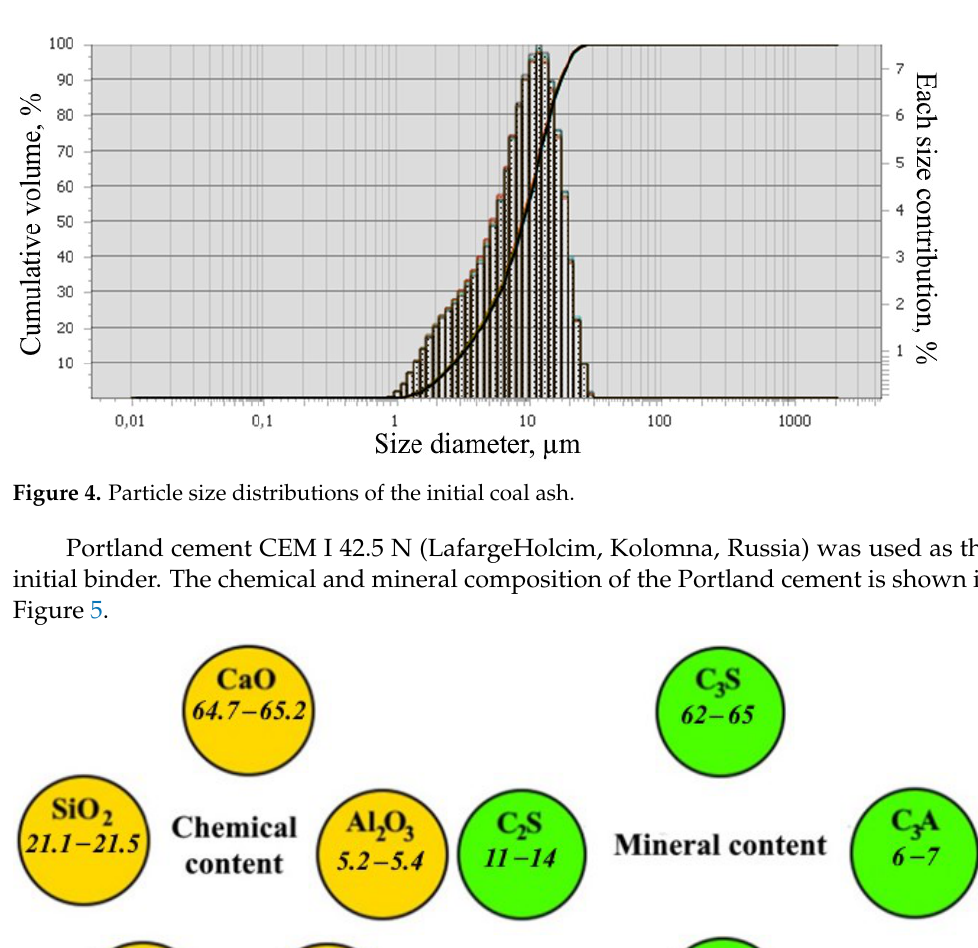
Figure 3. Chemical composition of the original coal ash.